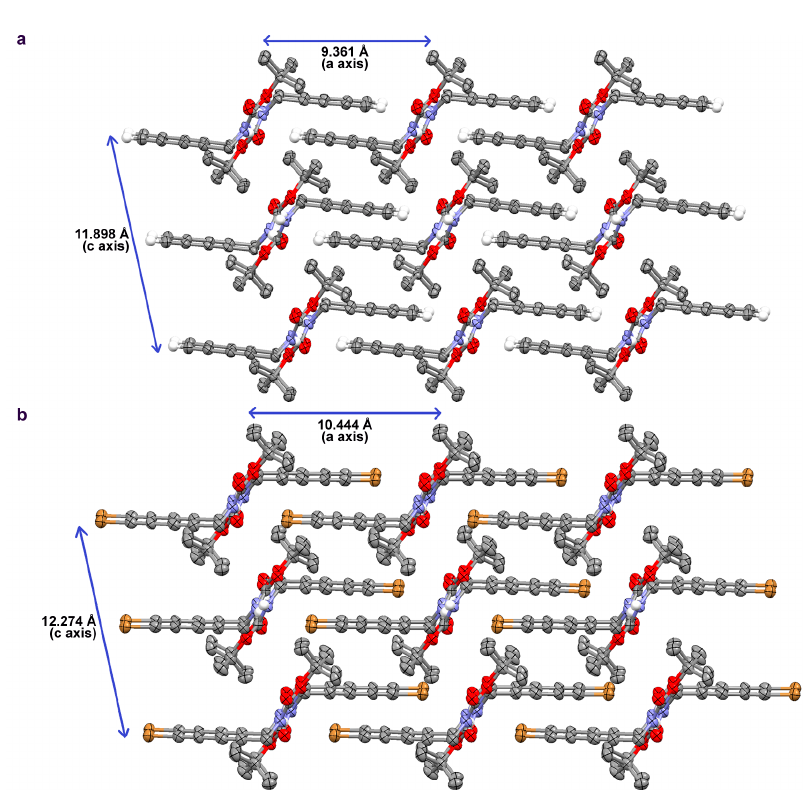
Figure 3. Top views of the supramolecular walls, seen along the b -axis of ( a ) diyne 1 and ( b ) bromodiyne 2 . The non polar hydrogen atoms have been removed for clarity. Table 1. Crystallographic data for diynes 1 and 2 .